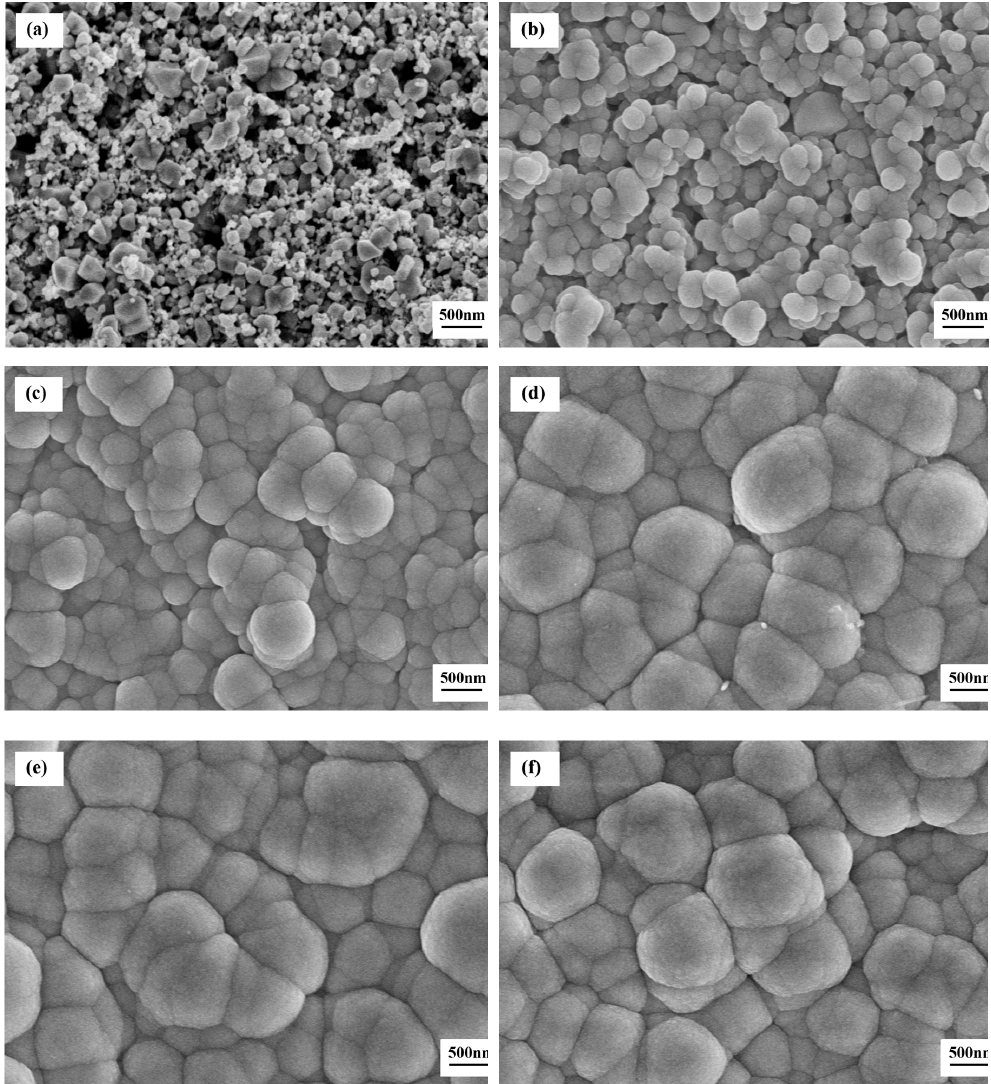
Figure 6. SEM micrographs of surface morphology of the sensors: ( a ) untreated, and CVD-treated at 500 ◦ C for ( b ) 2 h, ( c ) 4 h, ( d ) 6 h, ( e ) 8 h, and ( f ) 10 500 ° C for ( b ) 2 h, ( c ) 4 h, ( d ) 6 h, ( e ) 8 h, and ( f ) 10 h.